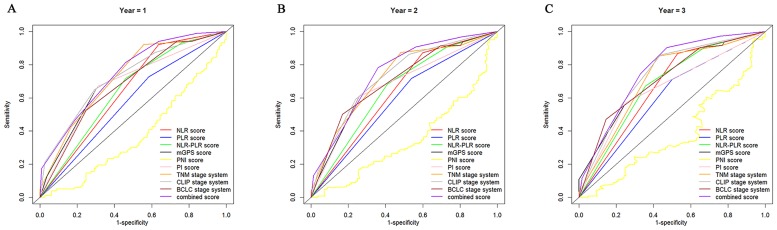
Comparisons of the AUROC values for the survival status between the inflammation-based prognostic scores and the staging systems at 1 (A), 2 (B), and 3-years (C).